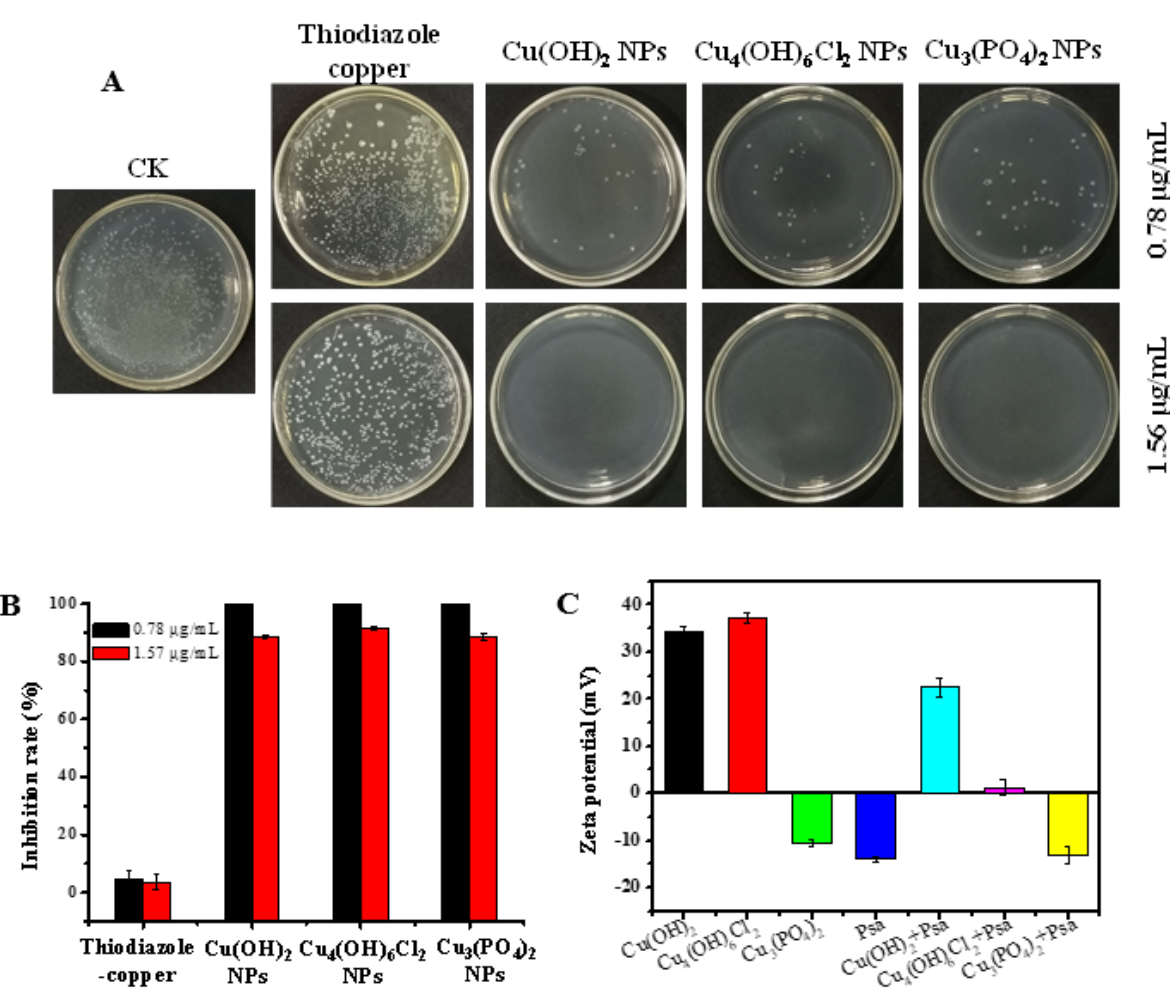
Figure 2. Antibacterial activity of copper-based nanomaterials. Agar plate photographs ( A ) and the inactivation efficiency ( B ) of Psa by copper-based nanomaterials was studied using a plate-counting method. Zeta potential of nanoparticles and the change of zeta potential after the interaction of nanoparticles with bacteria ( C ). CK: Negative control.